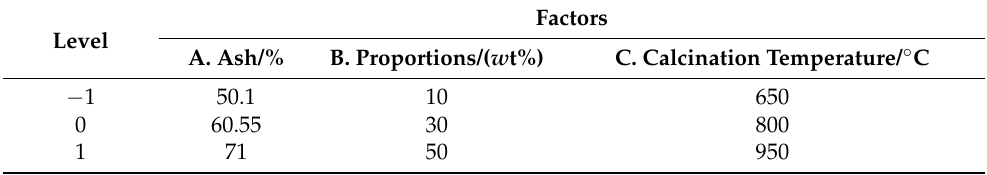
Table 2. Response surface test factors and levels. Level